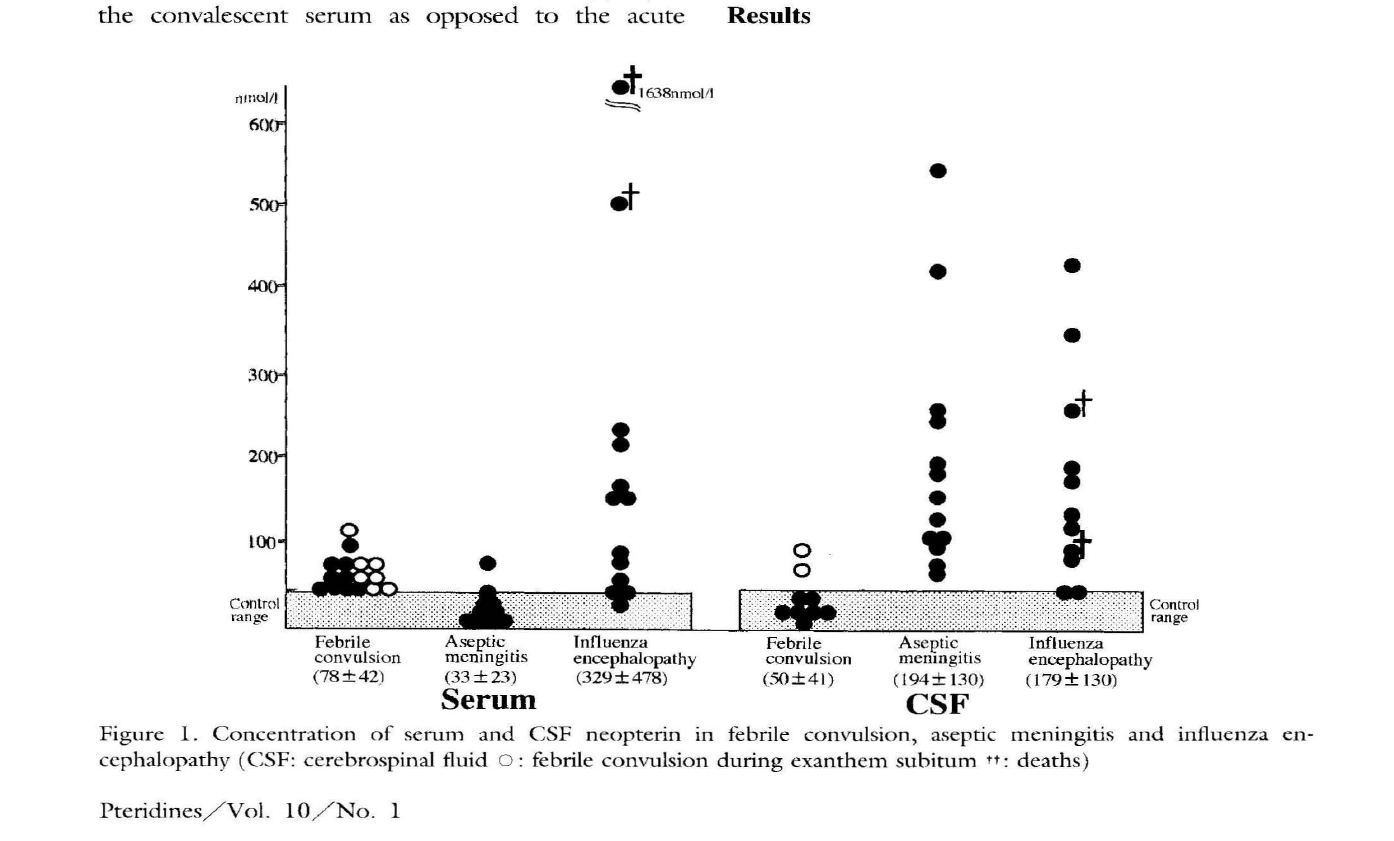
Figure 1. Concentration of serum and CSF neopterin in febrile convulsion, aseptic meningIus and influenza en cephalopathy (CSF: cerebrospinal fluid 0 : febrile convulsion during exanthem subitum tt : deaths) Pteridines/ Vol. IO/ No.